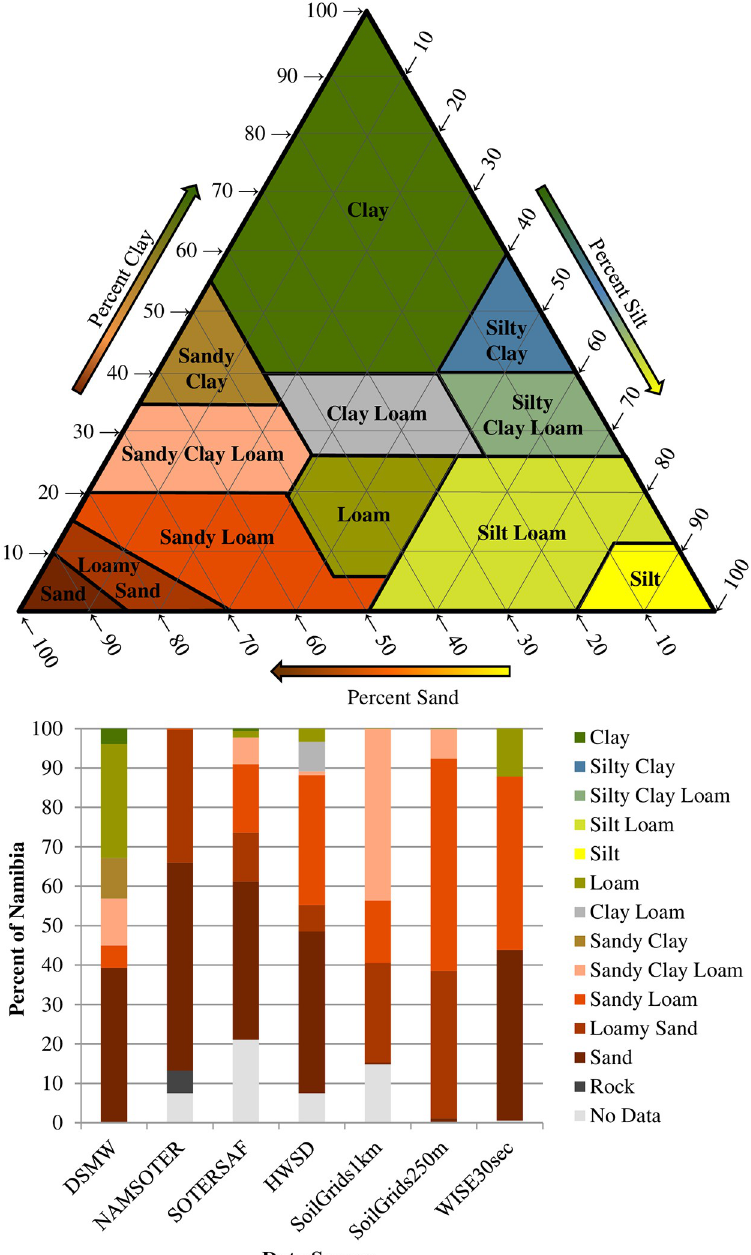
Fig 4. Soil texture triangle (top) and relative areal coverage of dominant topsoil texture types according to the seven map data sources (bottom). The map data sources include DSMW, NAMSOTER, SOTERSAF, HWSD, SoilGrids1km, SoilGrids250m, and WISE30sec. See the text for full names and versions of the map data sources. usually corresponds to pixel size. However, two of the raster maps were produced by rasteriza- tion of vector maps (i.e., conversion of a vector layer into a raster layer / here disaggregation of polygons into pixels) and so pixel size is a poor measure of the spatial detail in these prod- ucts. Following vectorization of these two maps (i.e., conversion of a raster layer into a vector layer / here aggregation of neighboring pixels of the same class into polygons) and ignoring